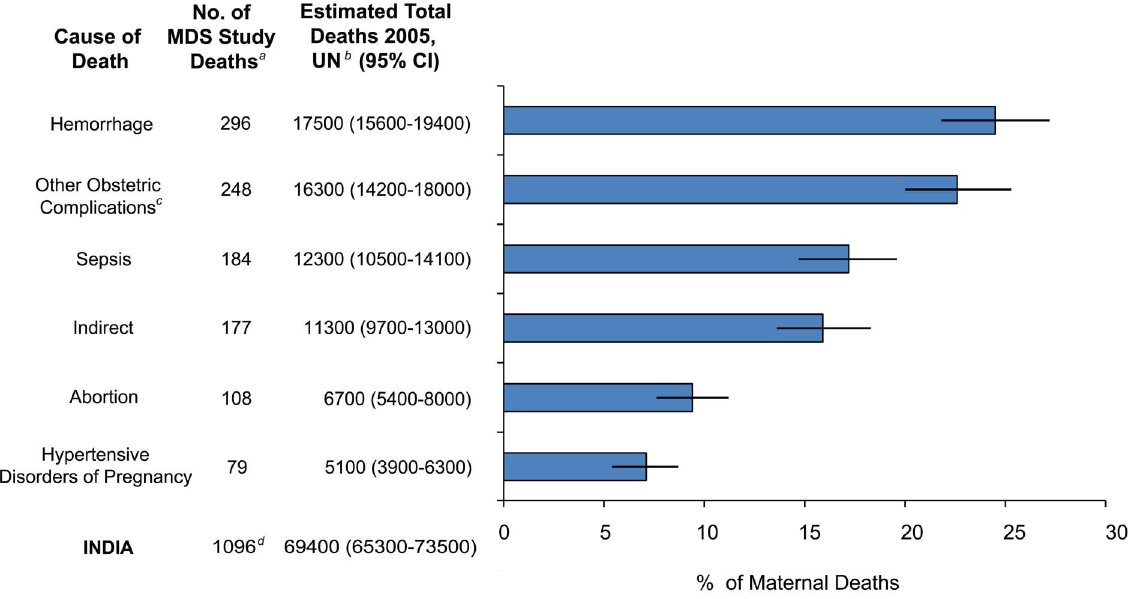
Figure 2. Cause of death distribution and estimation of annual number of maternal deaths by cause. Datasource: Indian SRS 2001–3 data, SRS 2004–6 MMR and UN live birth and death estimates for India 2005. ICD-10 categorization of cause of death [14] MDS - Million Death Study a Unweighted sample count of maternal deaths b Survey weighted, (95%CI), rounded to nearest 100th. c Includes ill-defined obstetric deaths (n=205), antenatal and postpartum suicide (n=24), vascular accidents (n=16), and uterine inversion (n=2). d Includes ‘unanticipated’ anesthetic complications (n=4). Compare with proportion of unweighted maternal deaths reported with RGI categorization: hemorrhage (38%, estimated total deaths for 2005=26 000), other (34%, total=23 500), sepsis (11%, total=7600), abortion (8%. total=5500), obstructed labour (5%, total=3400), and hypertensive disorders of pregnancy (5%, total=3400) [1].